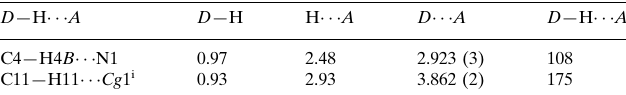
Hydrogen-bond geometry (A˚ , (cid:1)